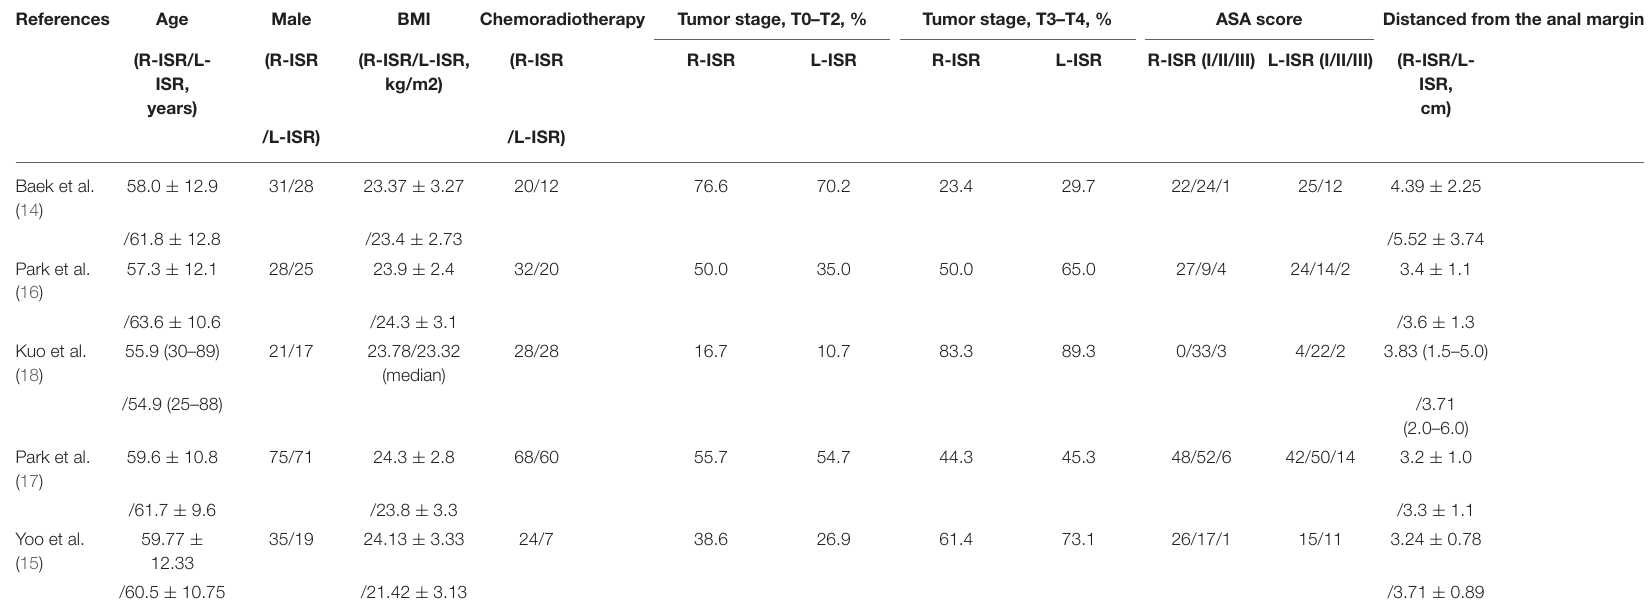
TABLE 2 | Patient